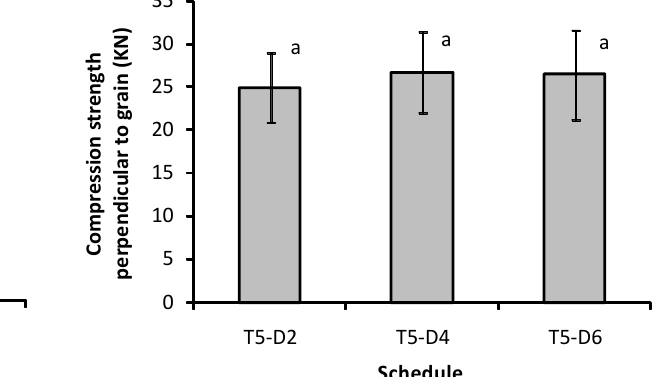
Fig. 2. Compression strength perpendicular to grain in the dried woods under the three adopted